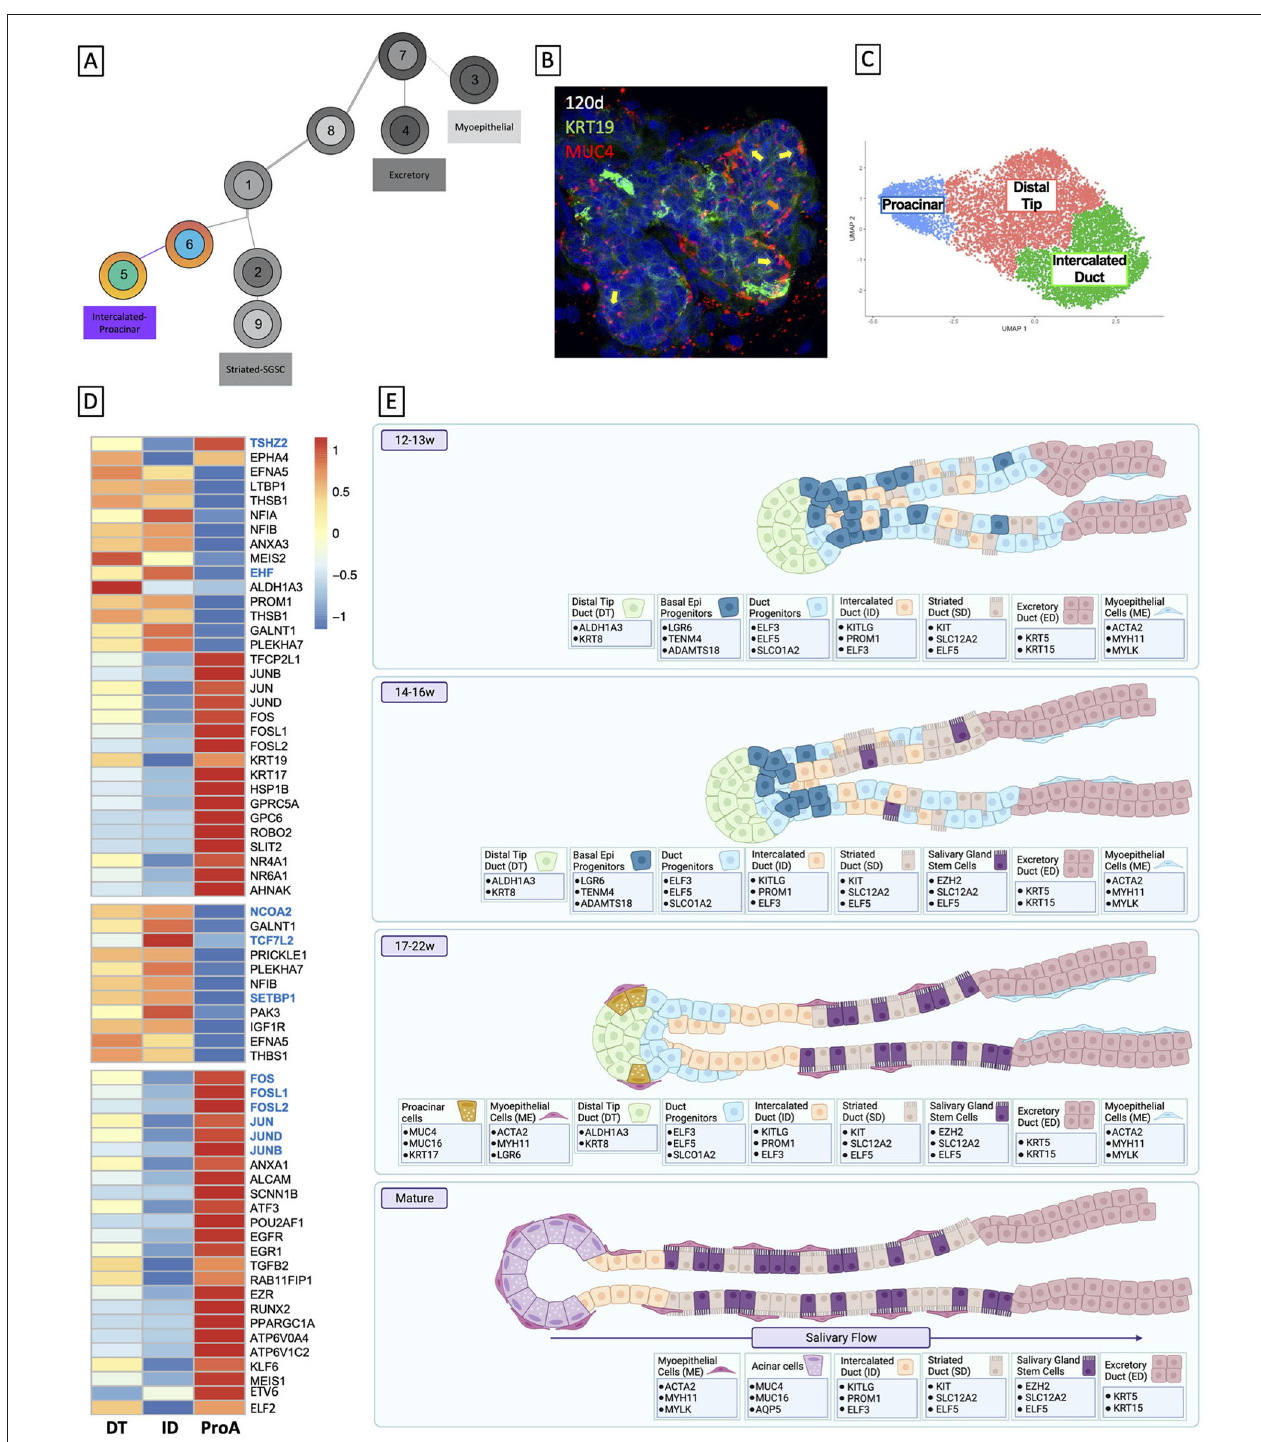
FIGURE 5 | Bioinformatic analysis introduces new potential regulators of acinar differentiation. (A) Trajectory analysis links ID (cluster 6) and a combined distal tip-proacinar cluster (cluster 5). (B) MUC4, acinar-associated mucin, was observed in tissues after 19w. (C) The plot of subset ID, distal tip, and proacinar cells. (D) Transcriptional analysis shows that DT shares significant transcriptional overlap with ID, and some limited transcriptional overlap with proacinar cells. CHEA3 analysis based on top genes in each cluster shows that TSHZ2 and EHF are responsible for the transcription of many tops expressed factors in the distal tip, while several AP-1 transcription factors drive top expression in the distal tip. (E) Our data have identified the presence of various progenitors and previously uncharacterized cell populations at different stages of development. Created using BioRender.